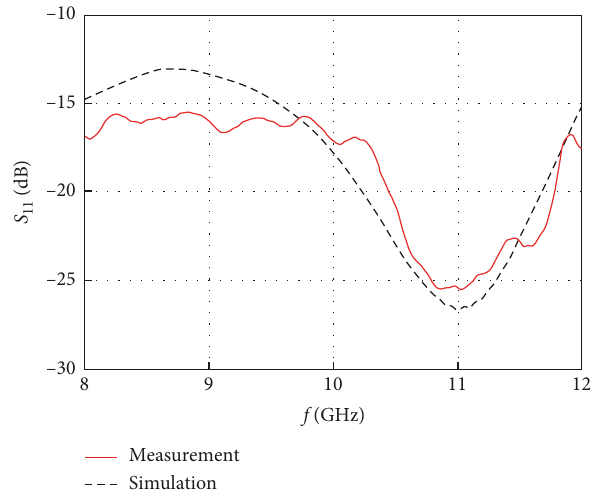
Figure 9: Reflection coefficient for an ultra-wideband dielectric lens antennas.